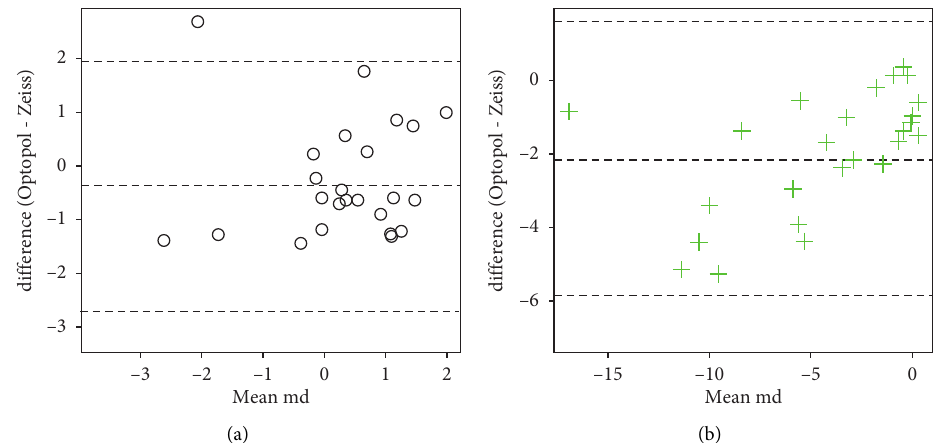
Figure 1: Bland–Altman plots for the visual field mean deviations. For each subject, the mean of the measurement from the Zeiss and Optopol machines is taken and plotted on the x -axis. The y -axis is the difference between the Optopol and Zeiss measurements. The plot on (a) is for control subjects; the plot on (b) is for subjects with glaucoma.